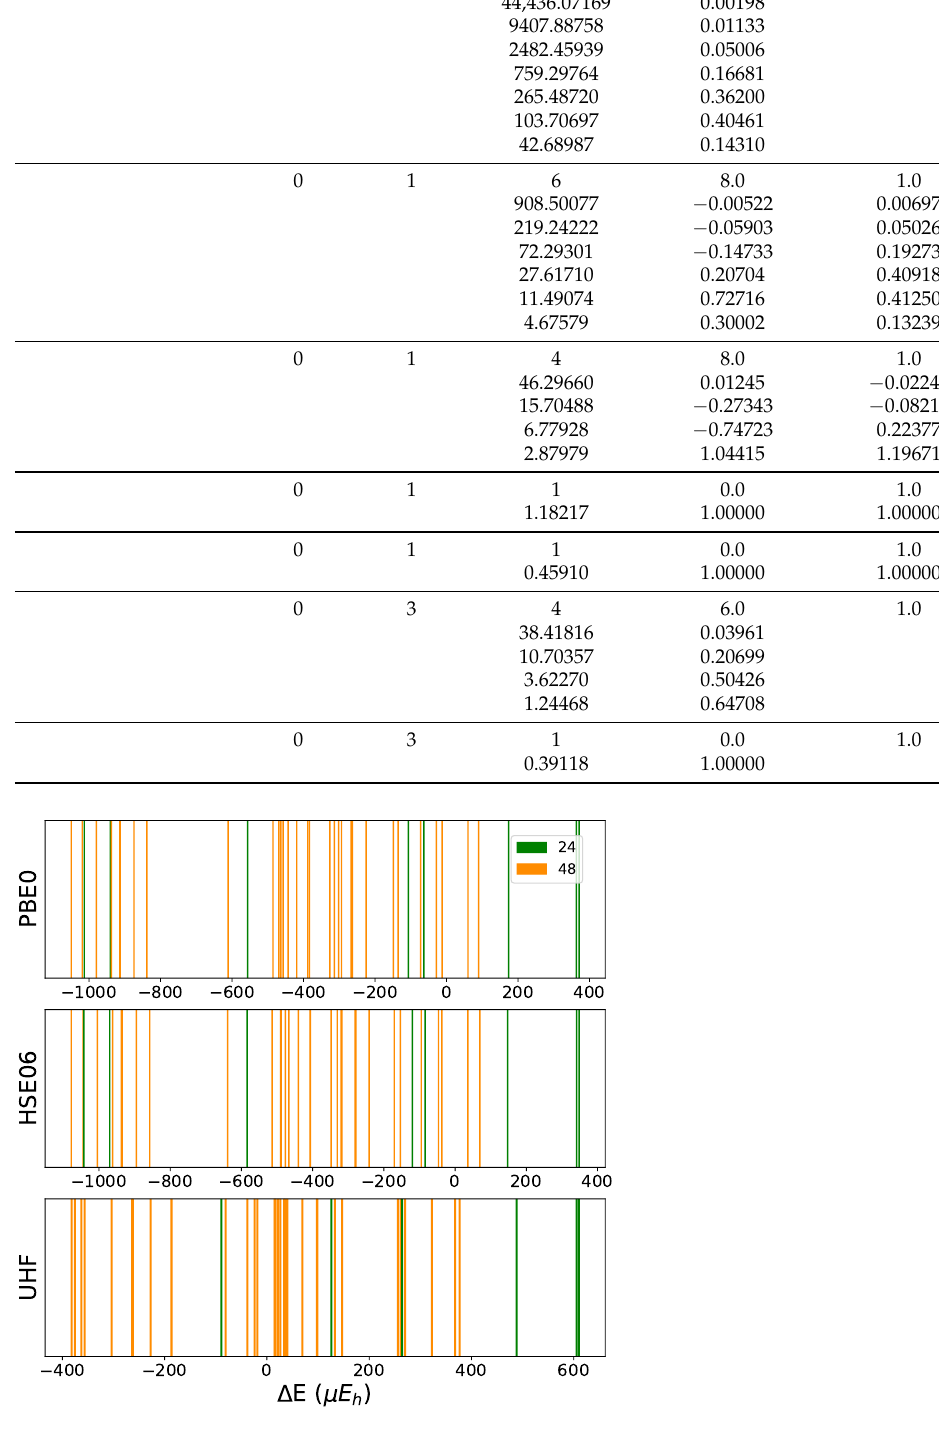
Figure A1. Distribution of the SICs belonging to the (2,3,3) CEC in relative total energy with respect to REF or (0,0,8) for 3 functionals: PBE0, HSE06 and UHF. Energy in µ E h per 2 f.u. For each SIC, the multiplicity is indicated. The B3LYP case is in Figure 5 ((2,3,3) panel) in the main